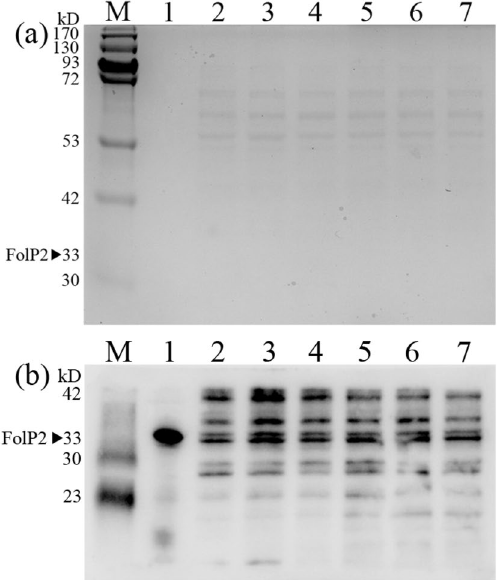
Figure 2. Comparison of the protein levels of FolP2 during the exponential phase in H37Ra, H37Ra folC (I43A), and H37Ra folC (I43T) strains, as indicated by western blot. Experiments were repeated at least three times, and representative results are shown. ( a ) Total protein (20 μg per lane) was separated by SDS-PAGE and stained by Coomassie brilliant blue. Lane M, the prestained protein marker. Lane 1, purified FolP2 protein. Lanes 2 and 3, total protein of H37Ra. Lanes 4 and 5, total protein of H37Ra folC (I43A). Lanes 6 and 7, total protein of H37Ra folC (I43T). ( b ) Western blot analysis of total protein immunoblotted with mouse antiserum with anti-FolP2. Lane 1, anti-FolP2 visualizing the purified FolP2 protein. Lanes 2 and 3, anti-FolP2 visualizing the total protein of H37Ra. Lanes 4 and 5, anti-FolP2 visualizing the total protein of H37Ra folC (I43A). Lanes 6 and 7, anti-FolP2 visualizing the total protein of H37Ra folC (I43T).